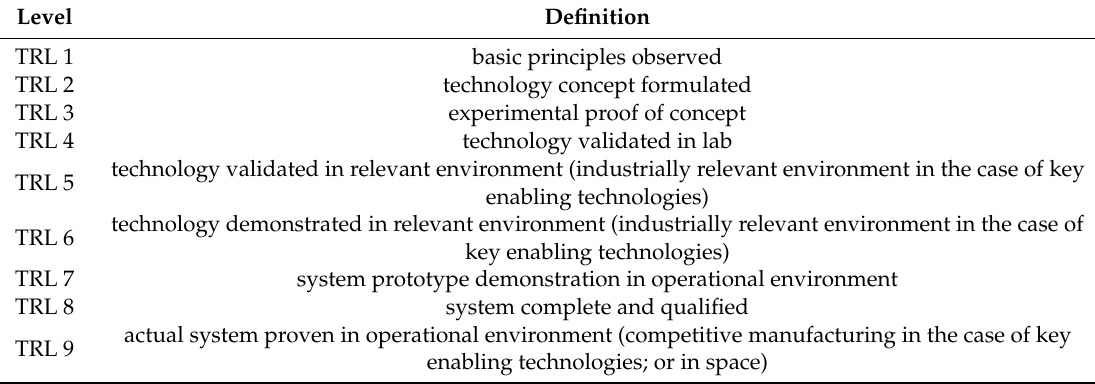
Table 1. European Commission’s classification and definitions of technology readiness levels